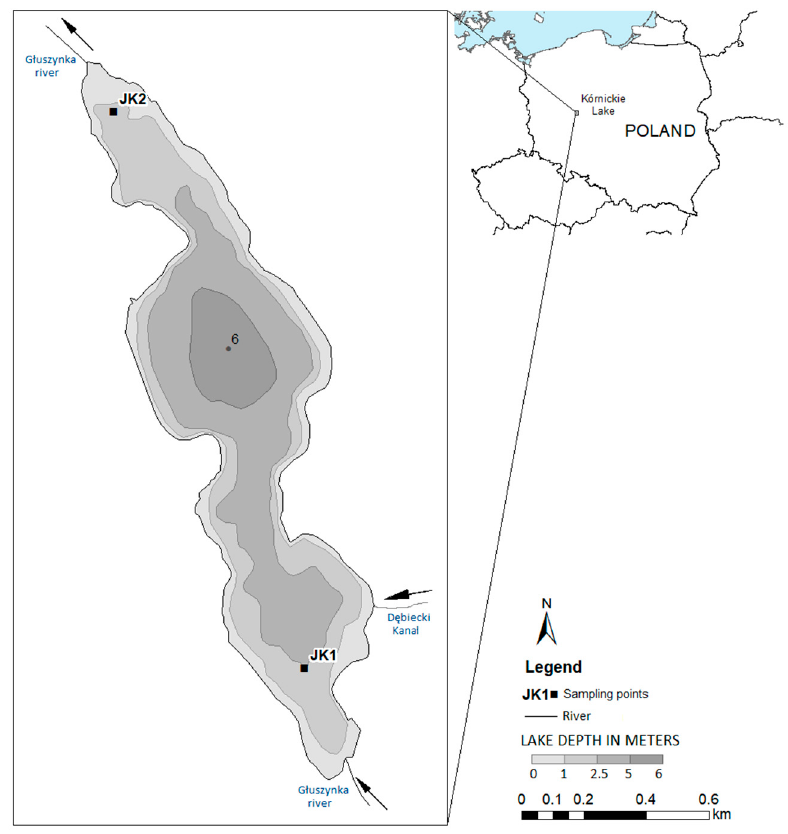
Figure 1. Study site location.